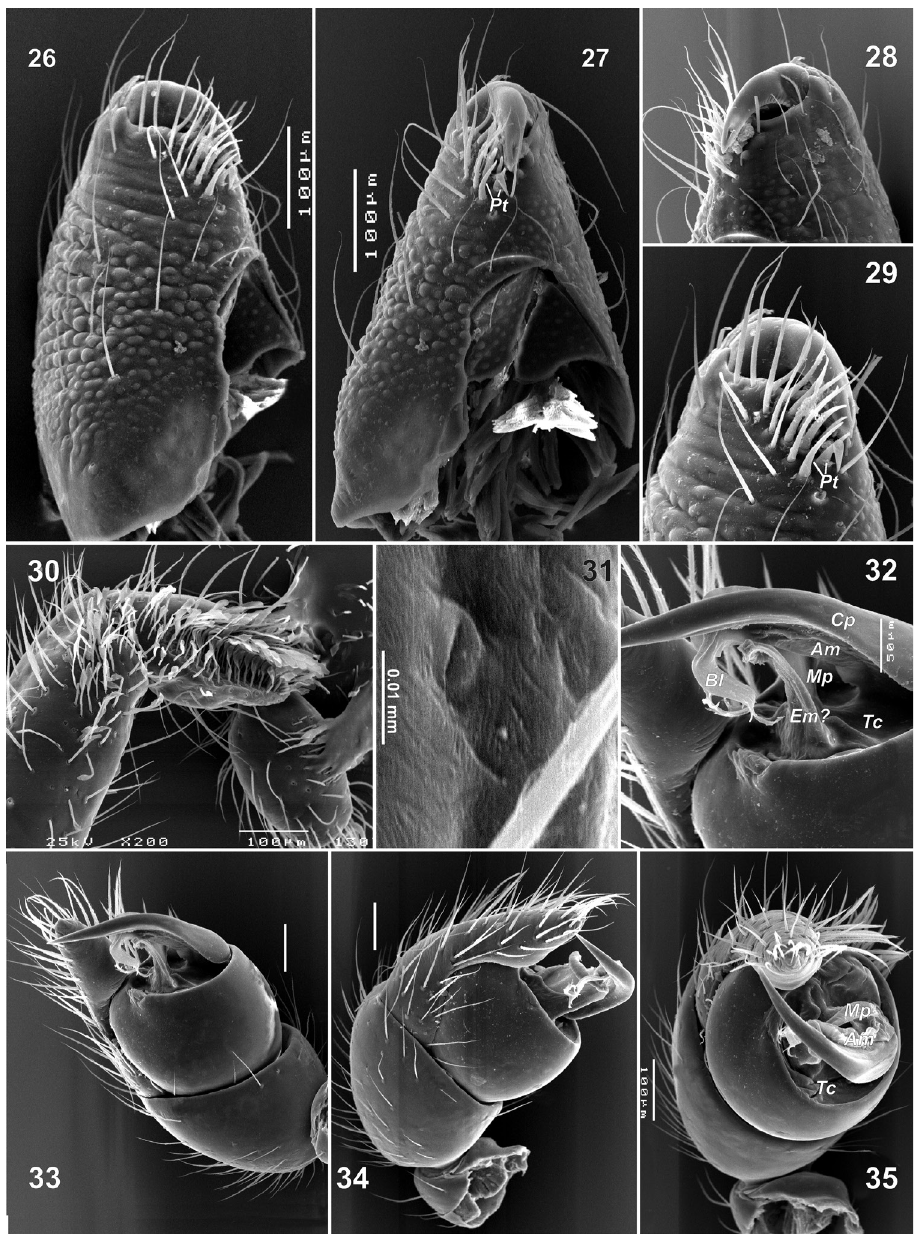
ventro-prolateral, prolateral and anterior. Abbreviations: Am accompanying membrane; Bl barbed tip of accompanying membrane; Cp claw-shaped process; Em? possible functional embolus; Mp membranous process; Tc tegular cavity. Scale bar: 0.1 mm if not otherwise